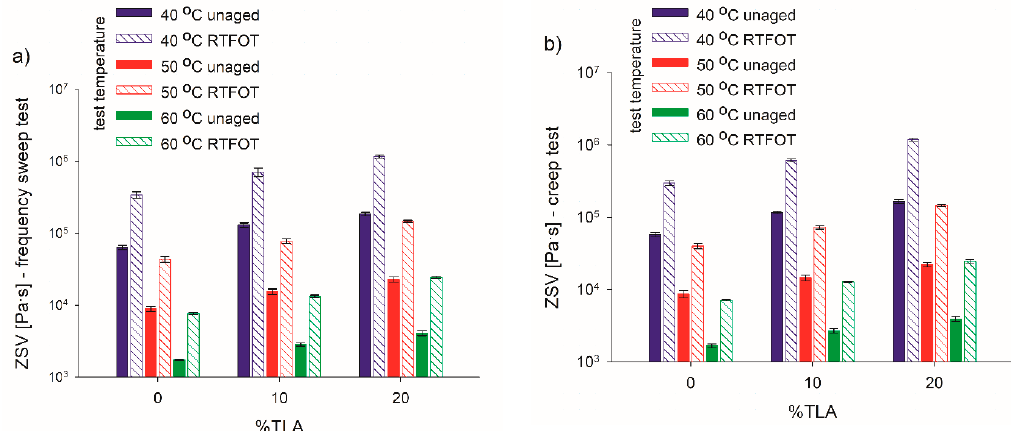
Figure 10. ZSV values of tested binders from the ( a ) frequency sweep test and ( b ) creep test models for various TLA content and test temperatures before and after aging.